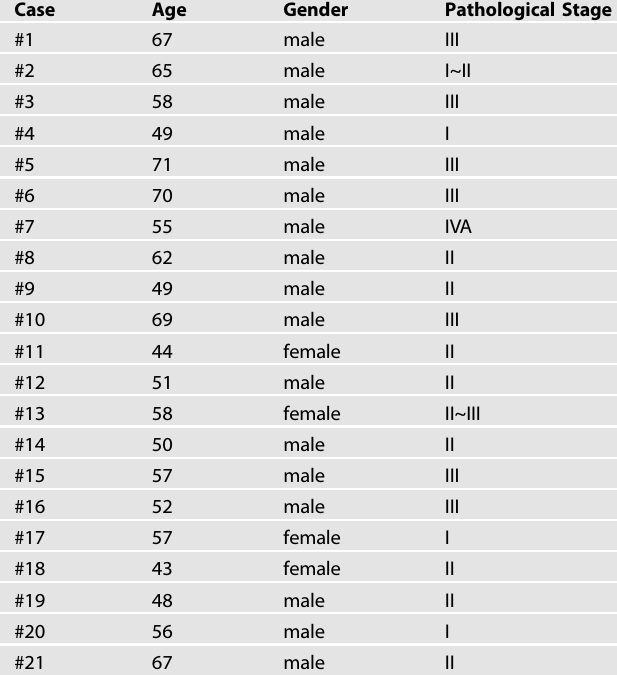
Table 1. Clinical features of 21 GC